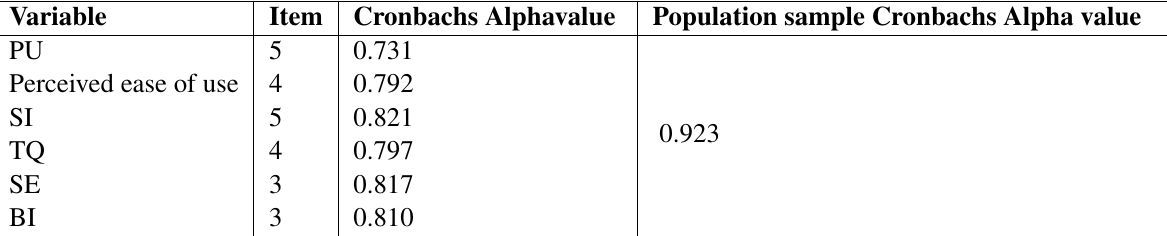
Table 10 Reliability analysis of the sample